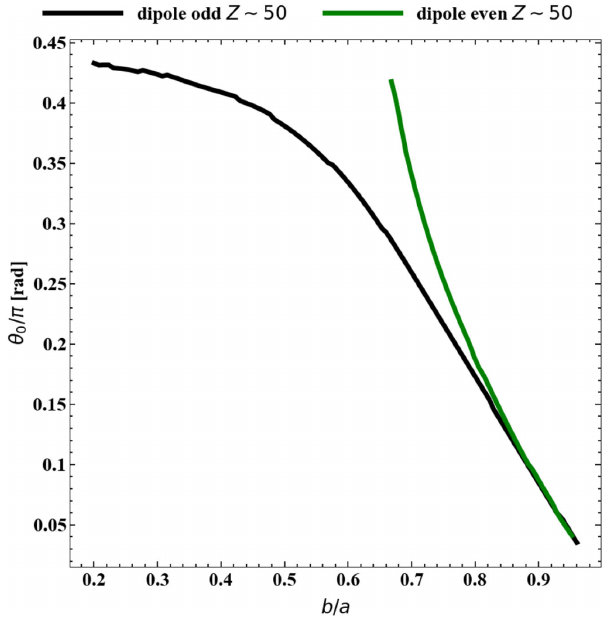
.FIG. 12. The angle θ 0 vs b=a at constant characteristic impedance Z in the two modes of the dipole kicker. The black c 50 Ω in the odd mode while the green curve has curve has Z c ¼ 50 Ω in the even Z c ¼